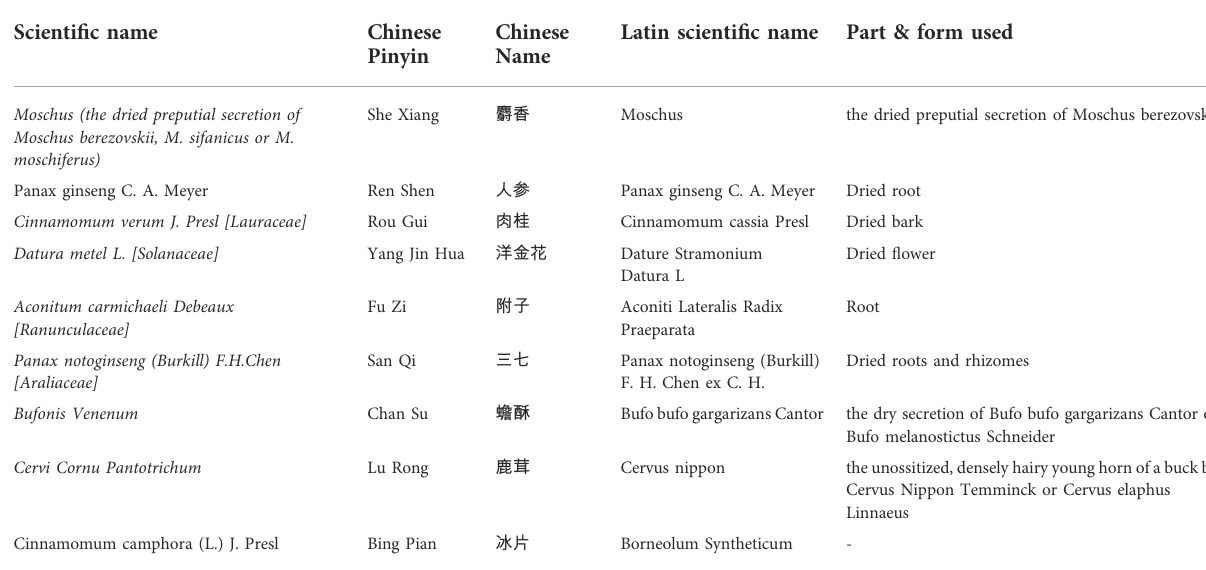
TABLE 1 Components of Xinbao pill (intervention